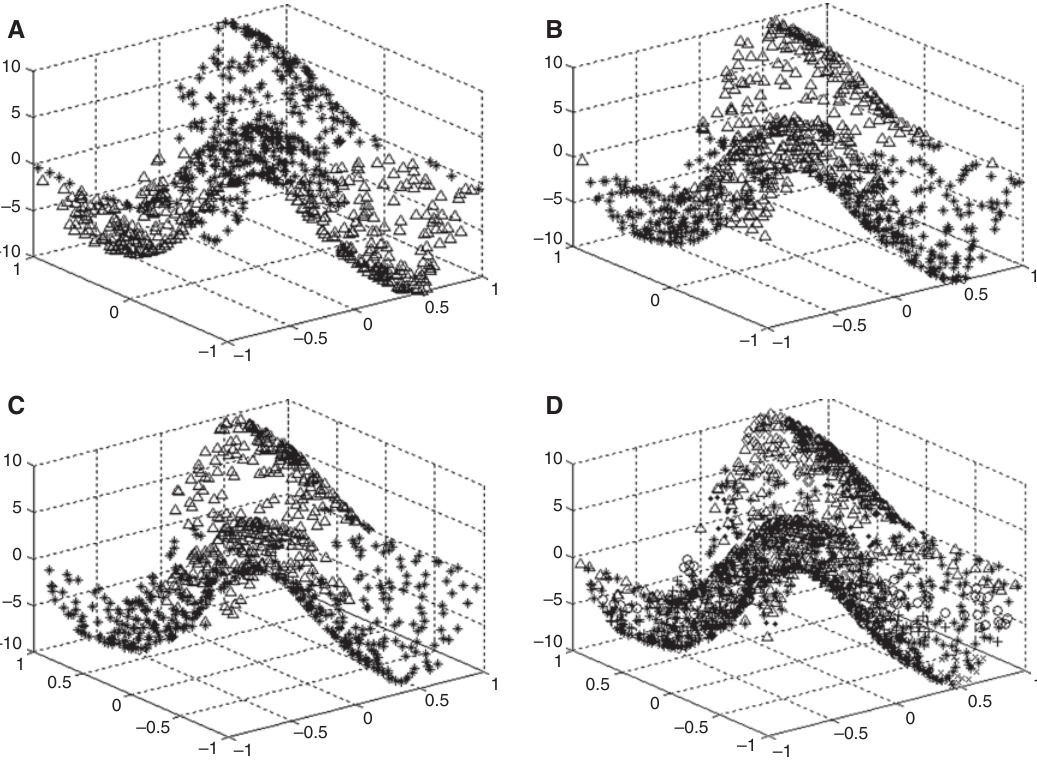
Figure 2: (A) Clustered Data 1 after the Application of KM for K = 2. (B) Clustered Data 1 after the Application of FCM for K = 2. (C) Clustered Data 1 after the Application of MHSC for K = 2. (D) Clustered Data 1 after the Application of MHSC for K = 7.